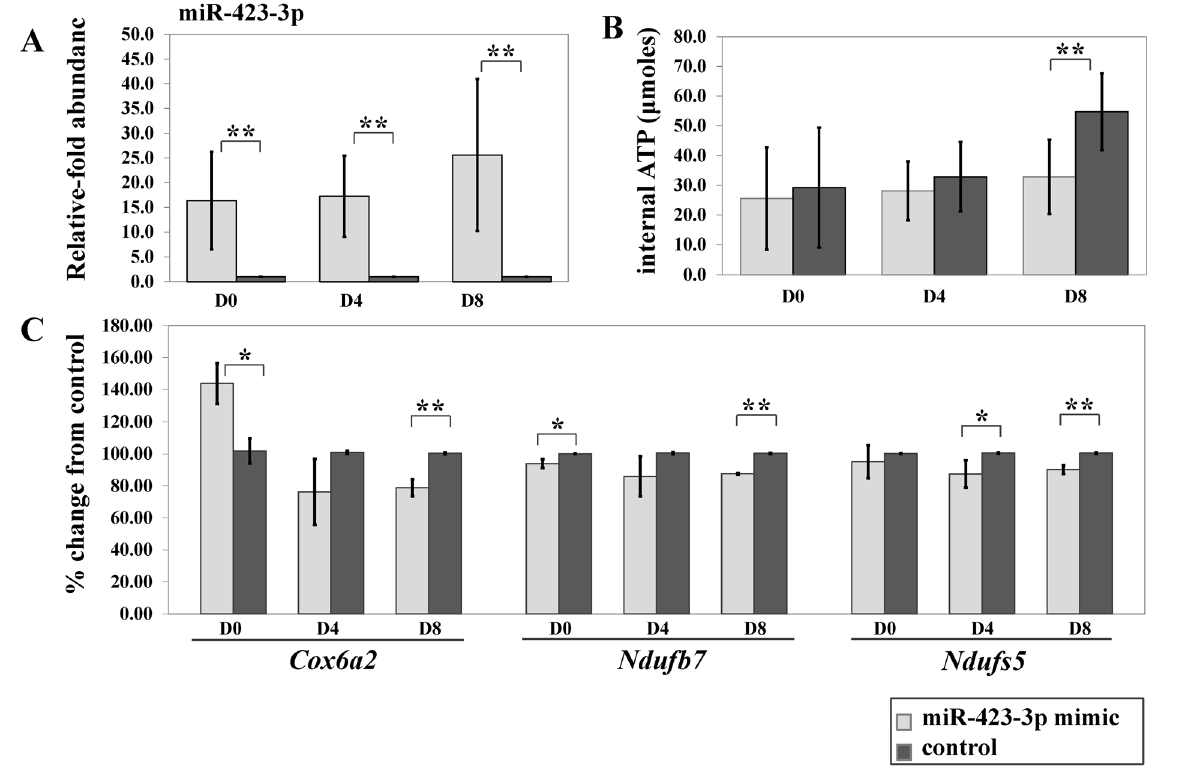
Fig 8. Transfection of synthetic miR-423-3p mimic negatively regulates Cox6a2, Ndufb7, and Ndufs5 as well as ATP level during C2C12 myotube induction. (A) Relative abundance of miRNA-423-3p by qPCR post miRNA-423-3p mimic transfection (n = 3). (B) 24 hours post-transfection, the cellular ATP level was lower (not significant) in the miR-423-3p mimic-transfected cells compared to the negative control at D0 and D4 and was significantly lower at D8. (C) Significant down-regulation of Cox6a2, Ndufb7, and Ndufs5 by qPCR 24 hours post-transfection. * and ** denotes p-values (cid:2) 0.05 and (cid:2) 0.01, respectively. All values are presented as mean ± SEM (n =